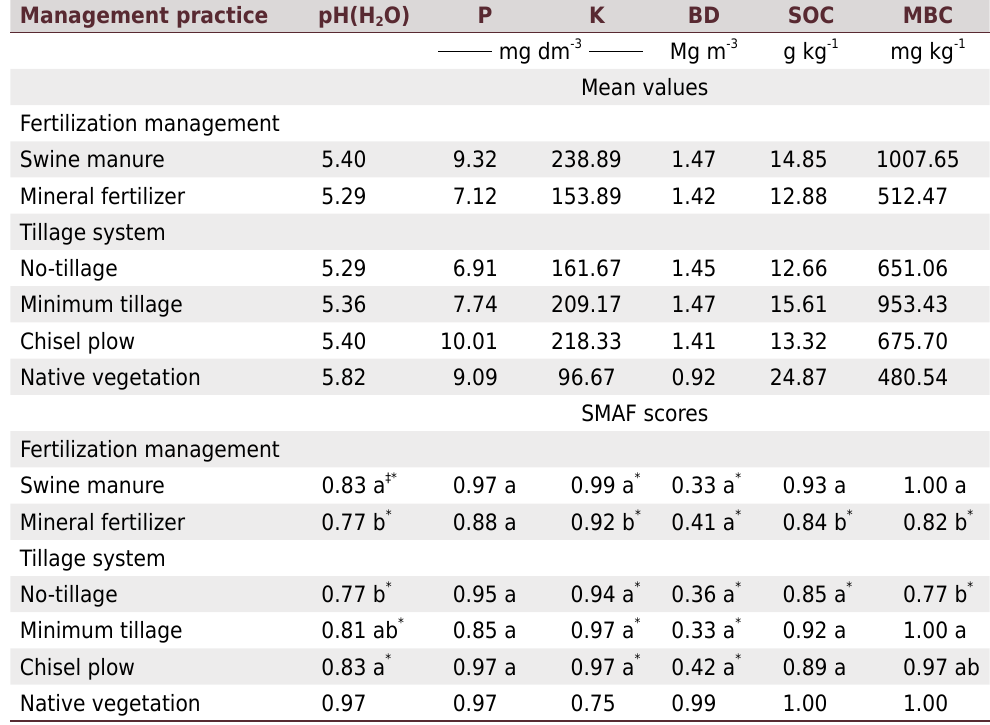
Table 4. Mean values and SMAF scores of soil quality indicators for the 0.00-0.10 m layer under fertilization management and tillage systems and under native vegetation Management practice